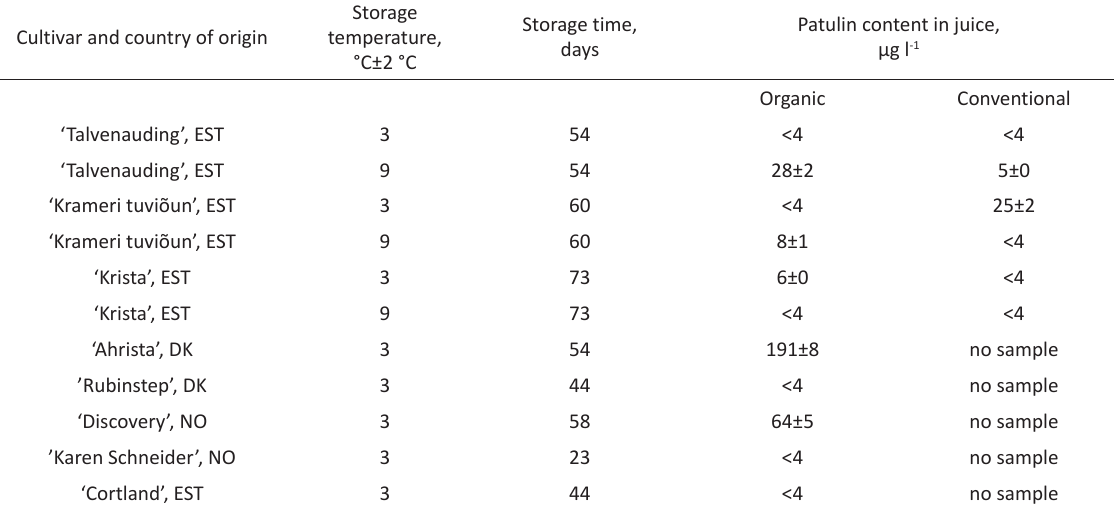
Table 1. Patulin content ( µg l -1 ) ± SE in apple juices in 2015 from Estonia (EST), Denmark (DK) and Norway (NO), as affected by organic and conventional cultivation system and pre-processing storage temperature of apples. Total number of analysed juices: 17 in three replications Cultivar and country of origin